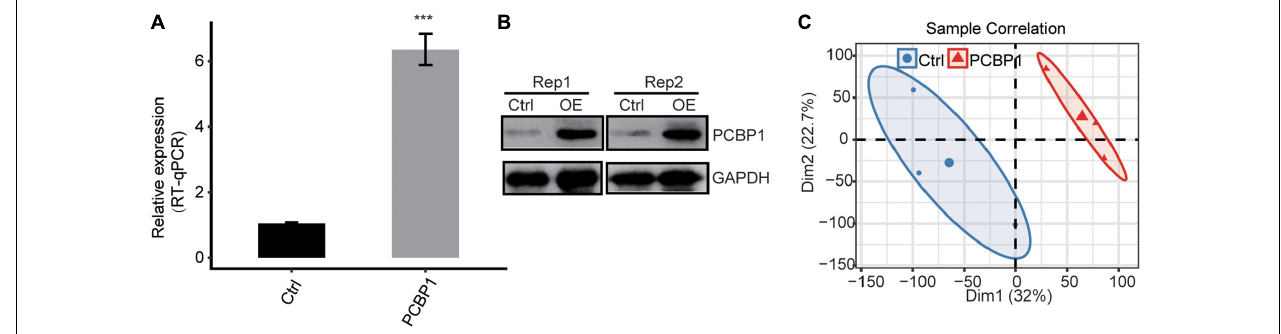
FIGURE 1 | PCBP-1 expression quantified by (A) qRT-PCR, (B) western blotting, (C) PCA of PCBP1-OE and control, based on FPKM values. Error bars represent mean ± SEM. *** P <